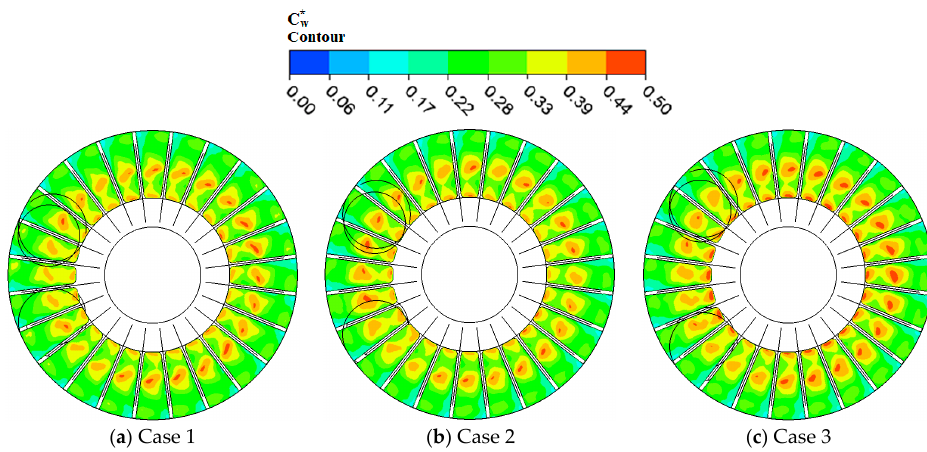
Figure 22. Velocity fluctuation intensity in impeller passage.